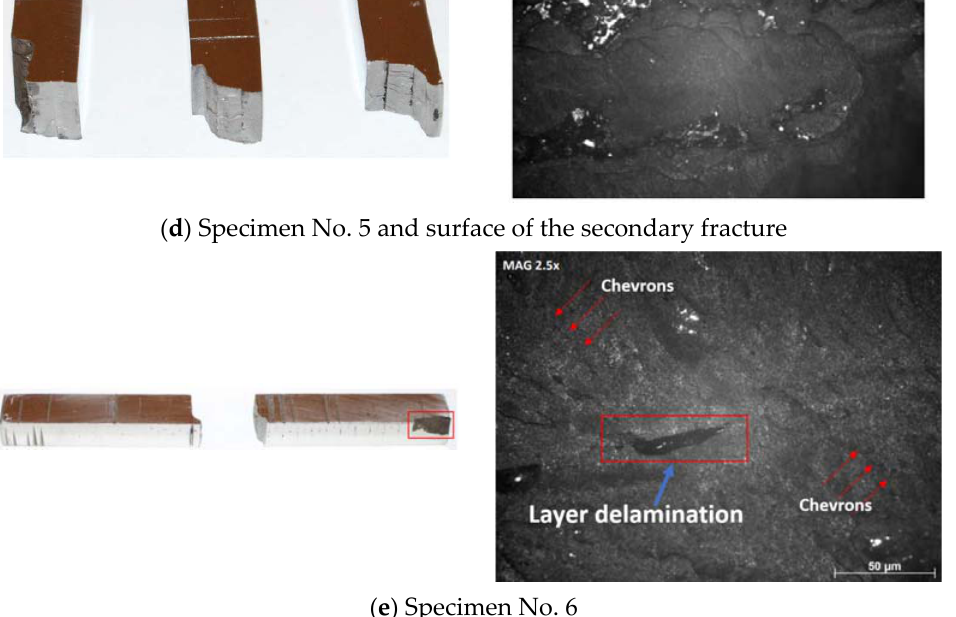
Figure 23. Fractured specimens and their respective surface